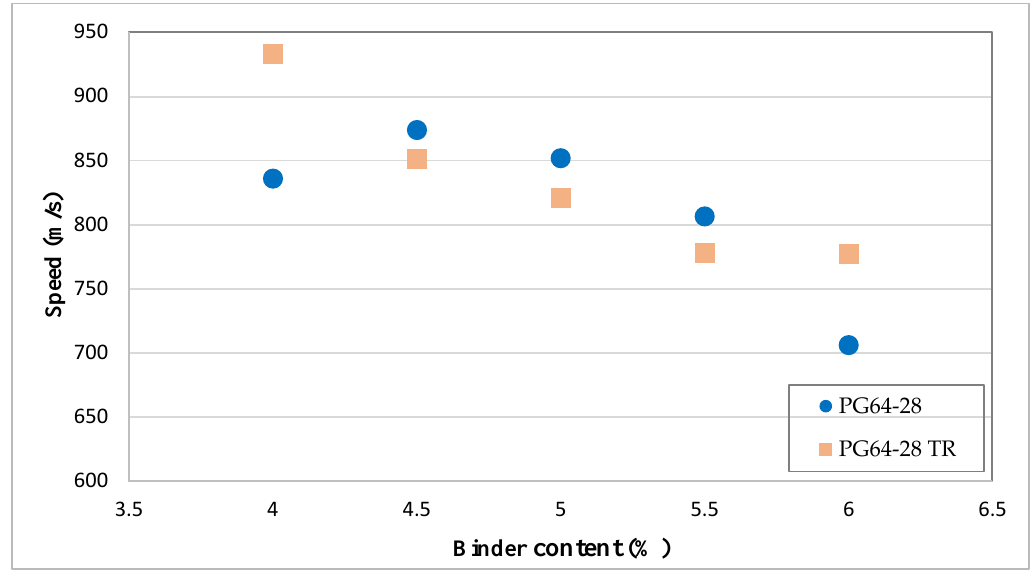
Figure 3. Wave speed trend with asphalt binder content for PG64-28 specimens.